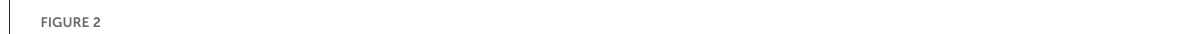
FIGURE2 animals that received two inflammatory stimuli [ICV NA and LPS or P3C, (B) ] compared to control mice that received saline ICV [ICV Sal, (A) ] or those injected IP with saline [ICV NA Sham in (B) ]. On the contrary, in TLR4 − / − mice treated with double stimulus the number of IBA1-positive cells did not increase [ICV NA and P3C, (B) ] compared to the same strain with only one stimulus (P3C in panel A and Sham in panel B ). Representative images of IBA1 labeled sections from mice treated ICV with saline (C–I) or with NA (J–P) . In WT and TLR2 − / − mice that received the double stimulus (K,L,N) microglial cells appear more densely distributed and present a reactive profile (darker, with thicker and shorter ramifications), compared to the same strain with only one stimulus [ (D,E,J) for WT; (G,M) for TLR2 − / − ]. Such difference is not observed in TLR4 − / − mice [ (P) compared to (I,O) ]. Bars in histograms A and B represent the mean ± s.d. of the plotted points [each point is the data of a single mouse; n = 3–4 in (A) , and n = 5–7 in (B) ]. Means were compared by three-way ANOVA ( P = 0.007). Letters a and b on top of the bars indicate the absence (if the same letter appears) or existence (if different letters appear) of a significant difference between the compared conditions, as indicated by Tukey’s test (P <